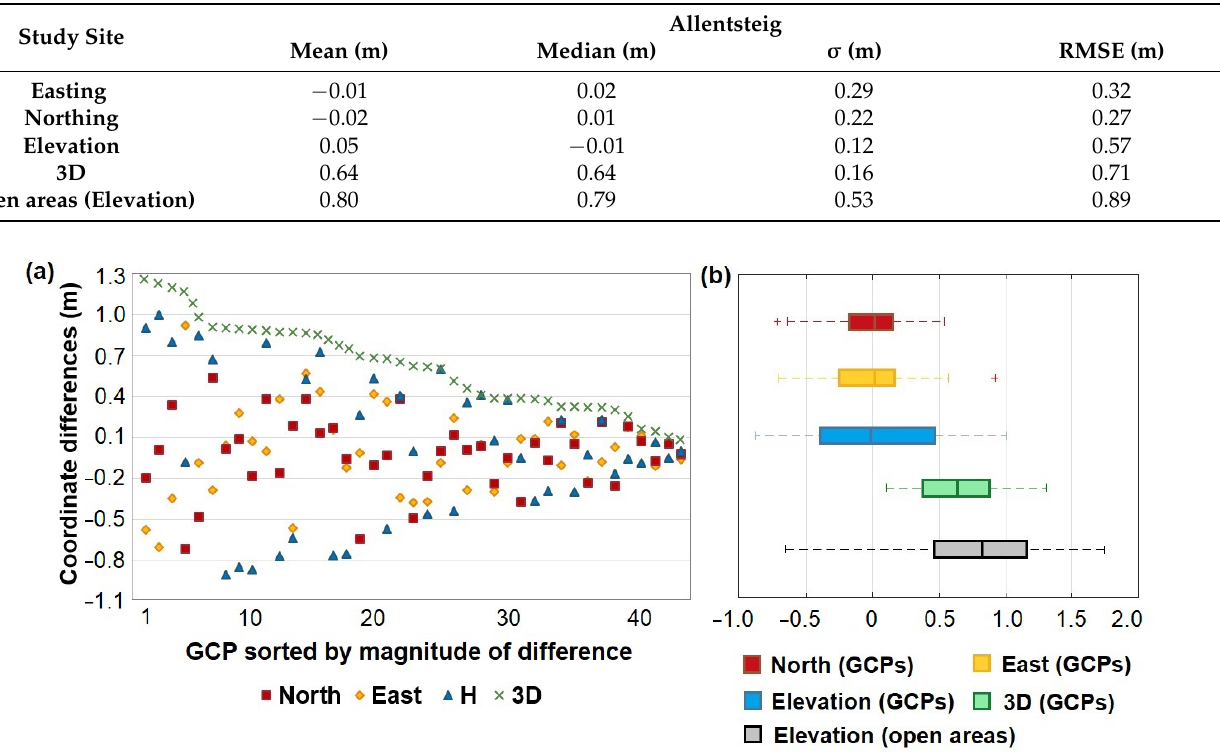
Figure 11. Differences between GCPs’ coordinates from terrain measurement to reconstruction from oriented satellite images: ( a ) Coordinate differences. ( b ) Statistics on GCPs’ coordinates and on elevations in open